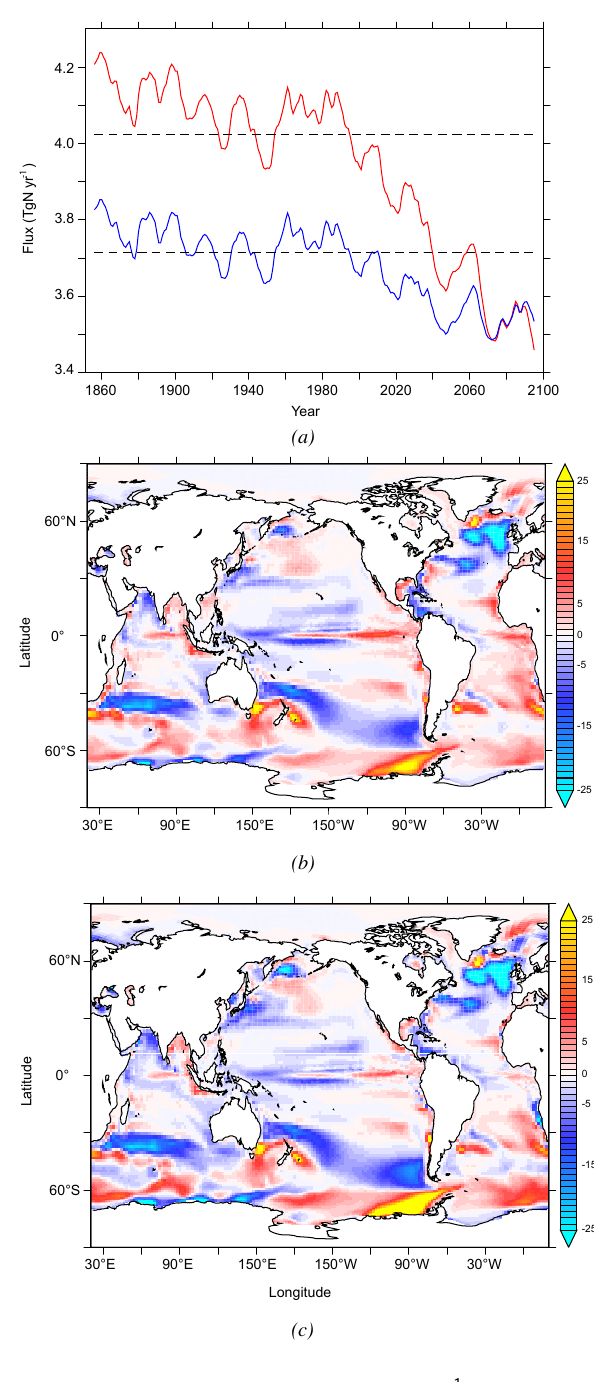
Figure 4. (a) N 2 O sea-to-air flux (in TgNyr − 1 ) from 1851 to 2100 in P.TEMP (blue) and P.OMZ (red) using the historical and future RCP8.5 simulations. Dashed lines indicate the mean value over the 1985 to 2005 time period. Change in N 2 O sea-to-air flux (mgNm − 2 yr − 1 ) from the averaged 2080–2100 to 1985–2005 time periods in future RCP8.5 and historical simulations in (b) P.TEMP and (c) P.OMZ